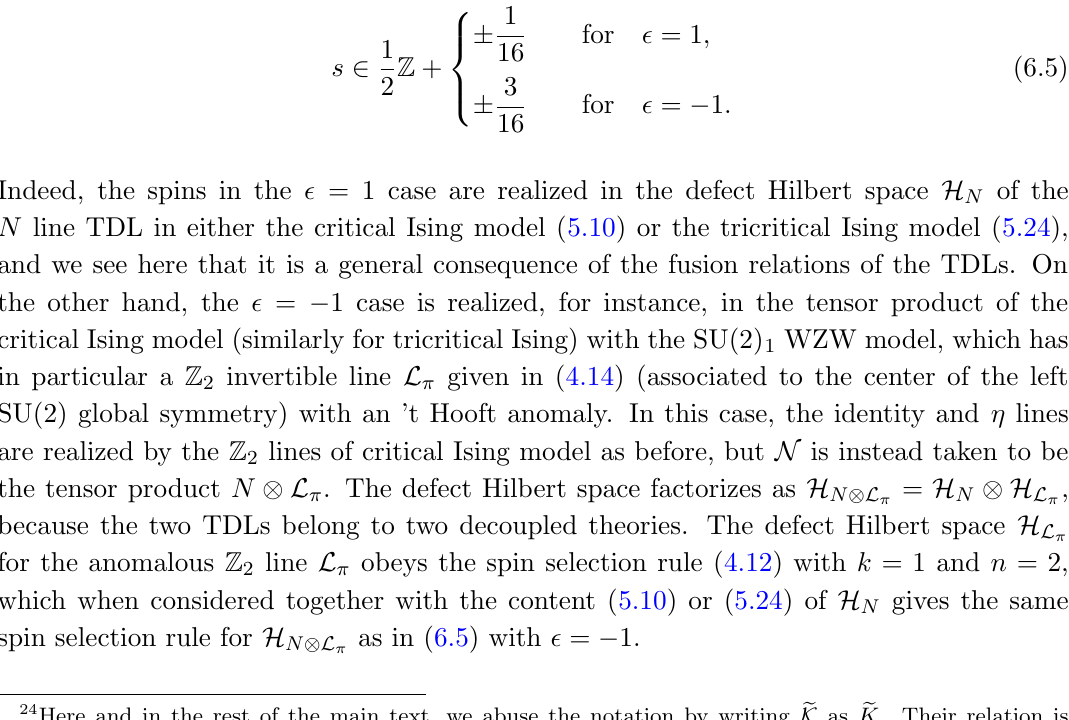
(cid:17) + (right) on H N b